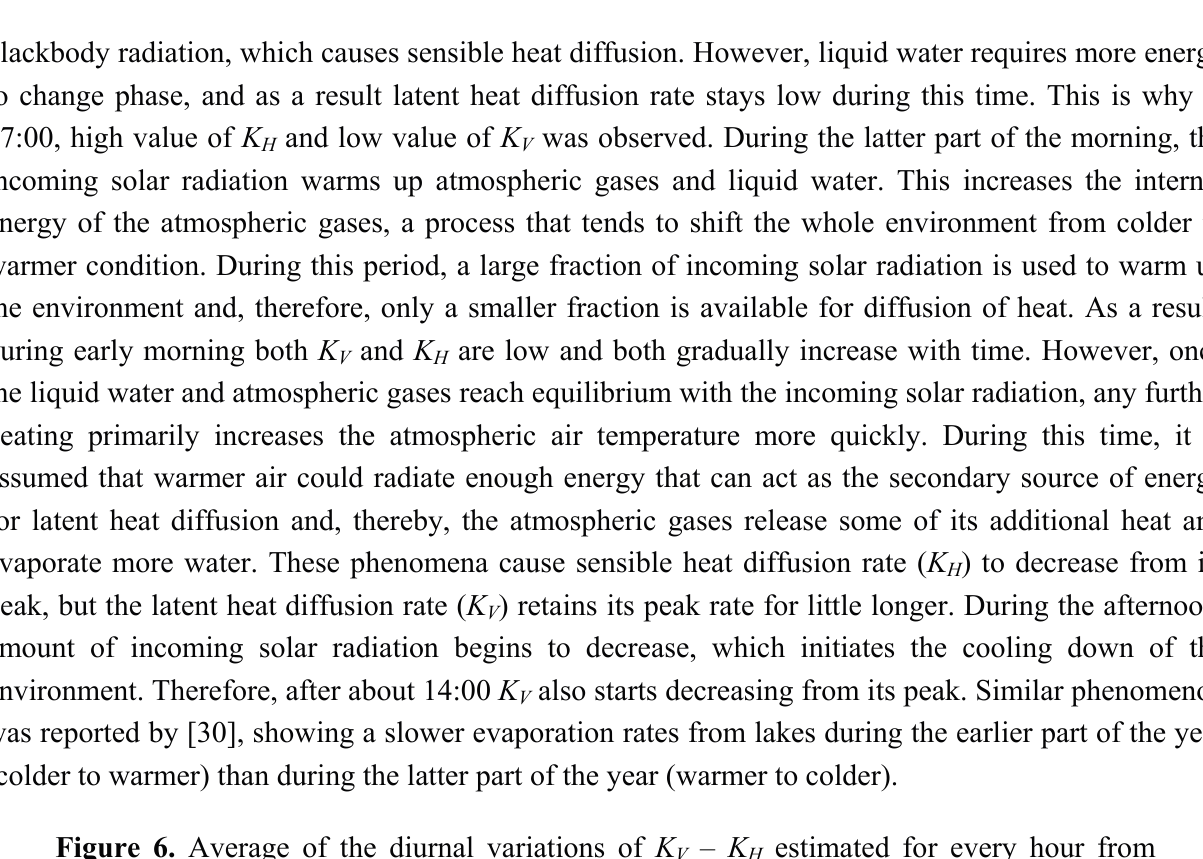
– K in the Y-axis are the averages of K V H